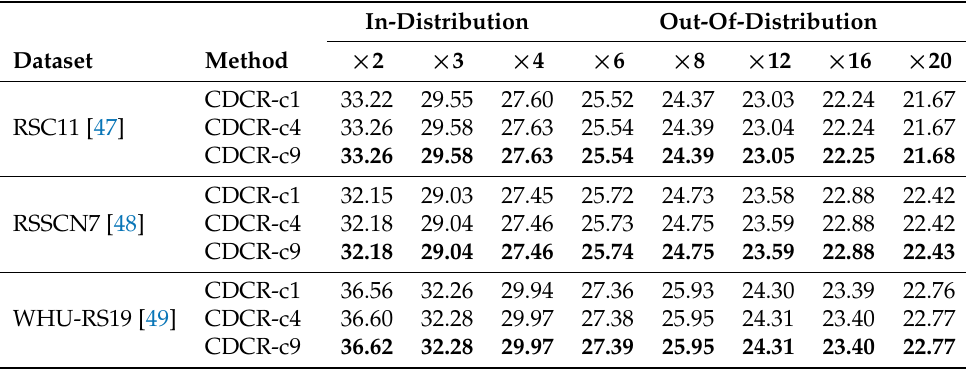
Table 2. Ablation experiment on dense prediction. -c1 represents no dense prediction, -c4 represents semi-dense prediction, and -c9 represents dense prediction. The optimal PSNR values for each scale factor across different datasets are emphasized in bold